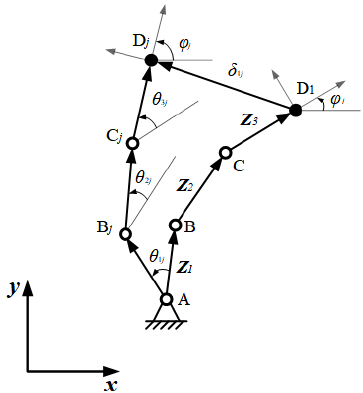
Figure 5. Planar 3R serial chain in two finitely separated